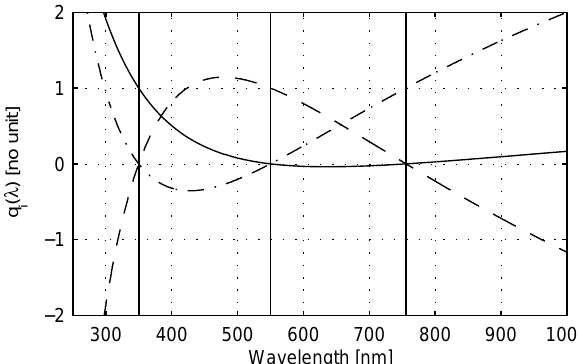
Figure 2. Aerosol spectral functions q 1 (λ) (solid), q 2 (λ) (dashed) and q 3 (λ) (dash-dot) for a quadratic polynomial of inverse wave- length. The three predefined wavelengths are λ 1 = 350nm, λ 2 = 550nm, and λ 3 = 756nm (vertical